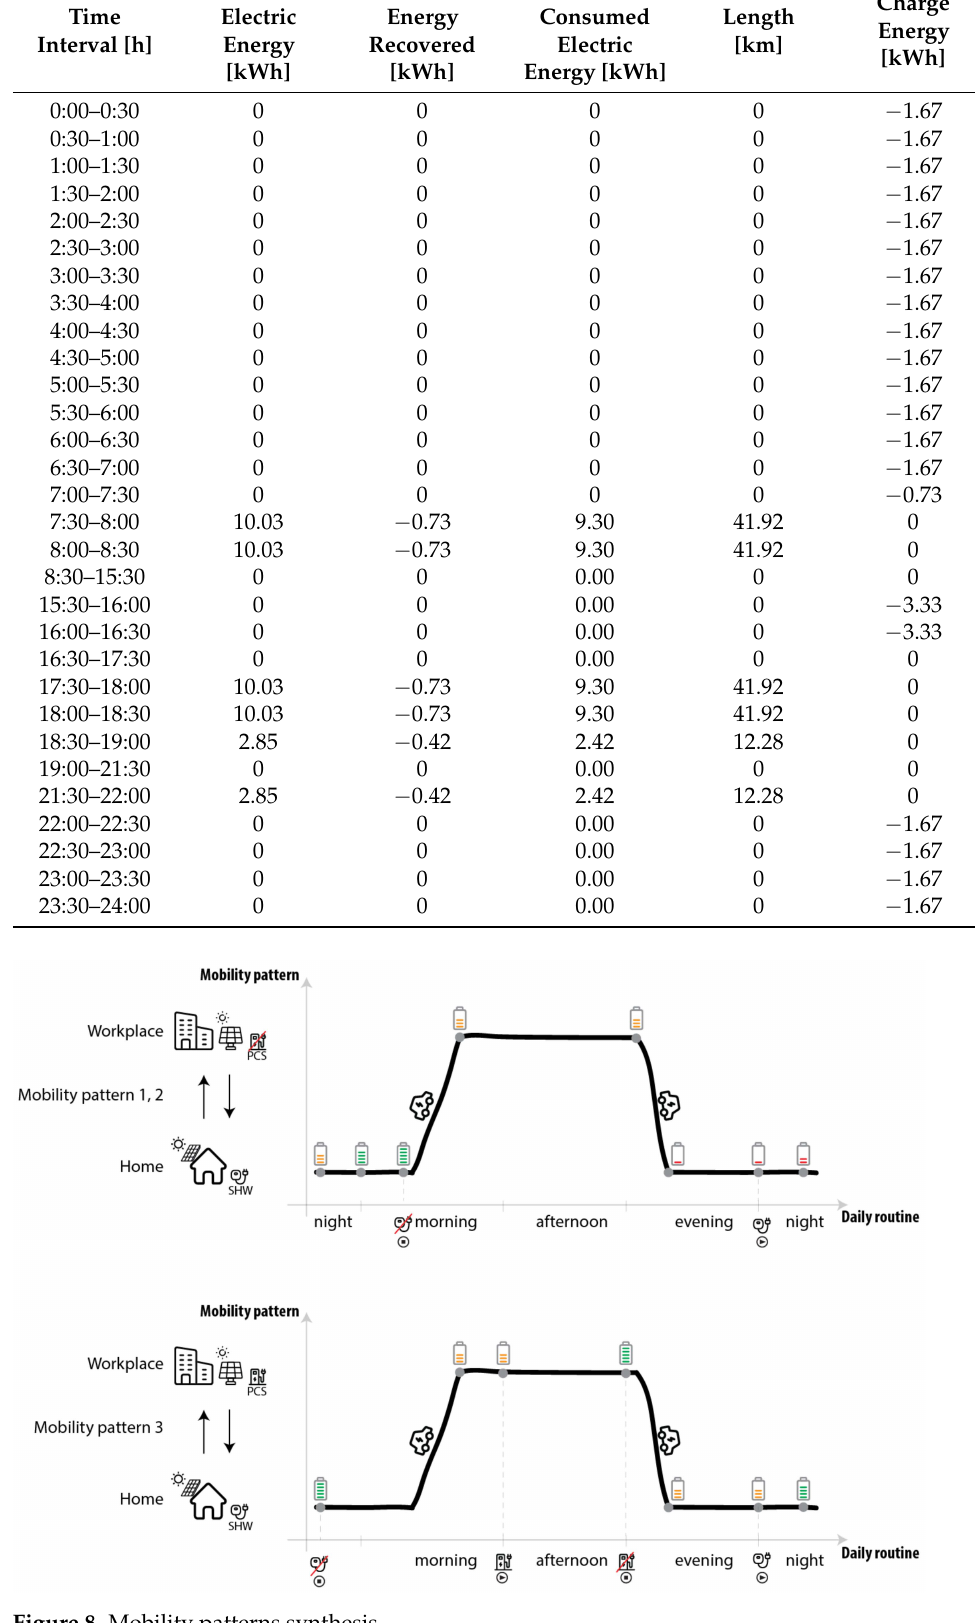
Figure 8. Mobility patterns